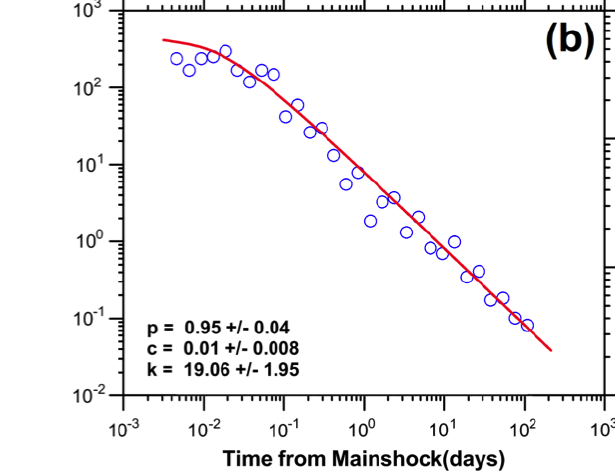
Figure 4. Temporal change of the number of aftershocks per day for both the aftershock sequences of (a) first ( M 7.2) main-shocks of Nepal earthquake sequence along with their relevant respective parameters p , c and K -values in the modified ( M W Omori’s